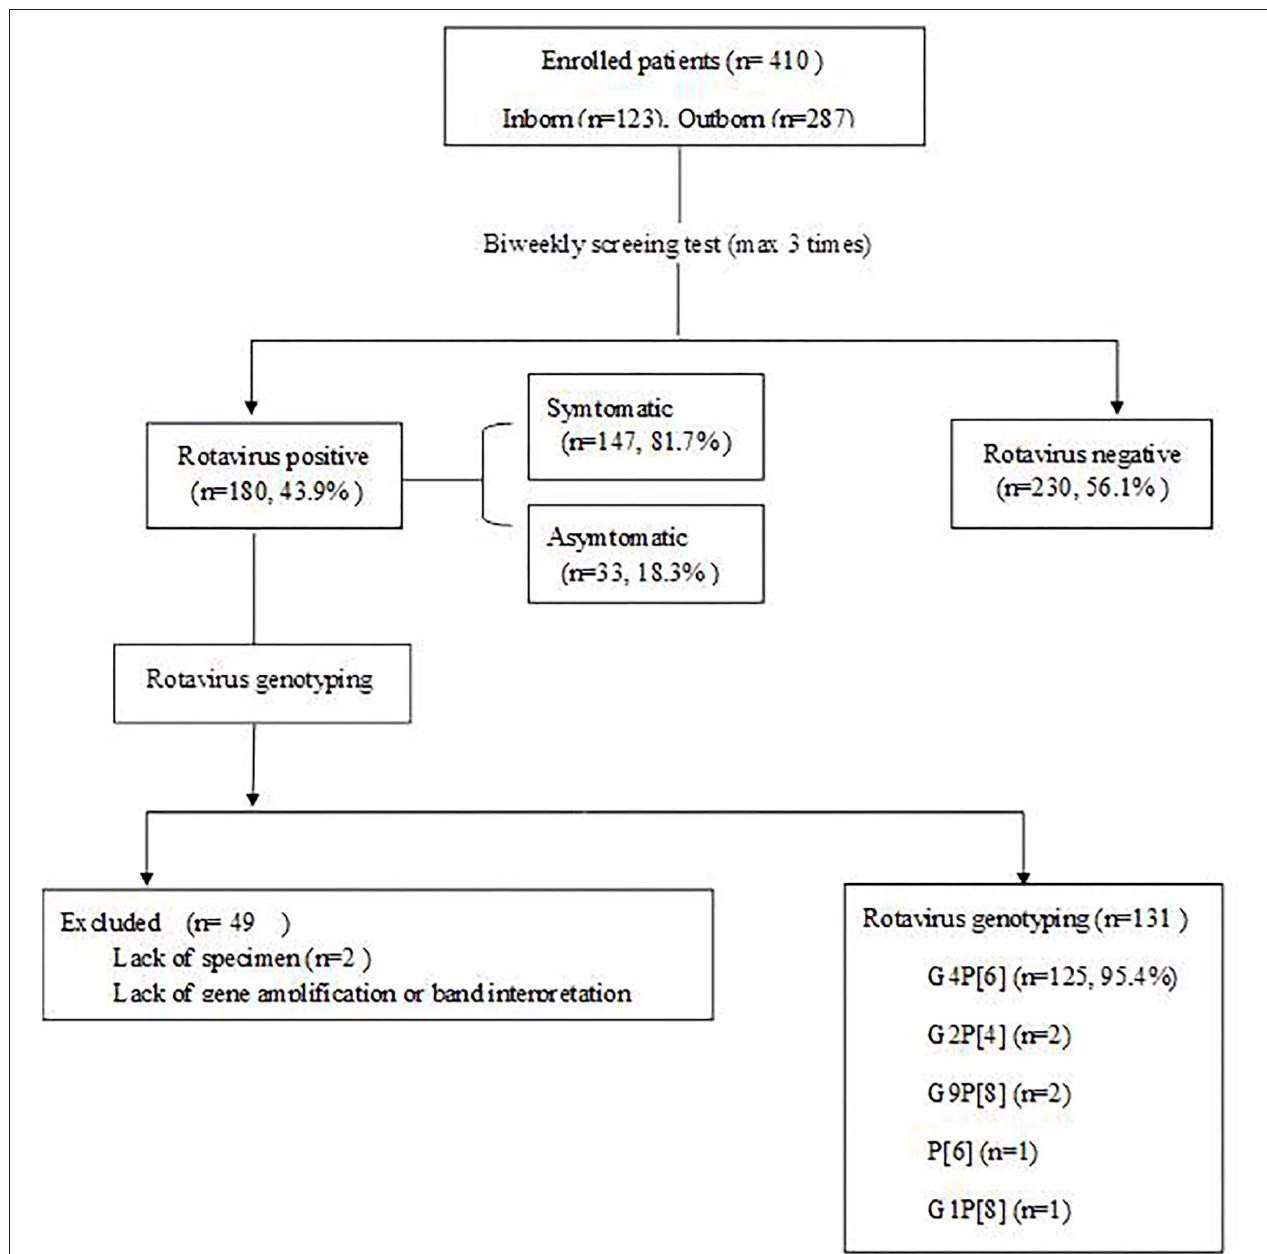
FIGURE 1 | Flow diagram of study